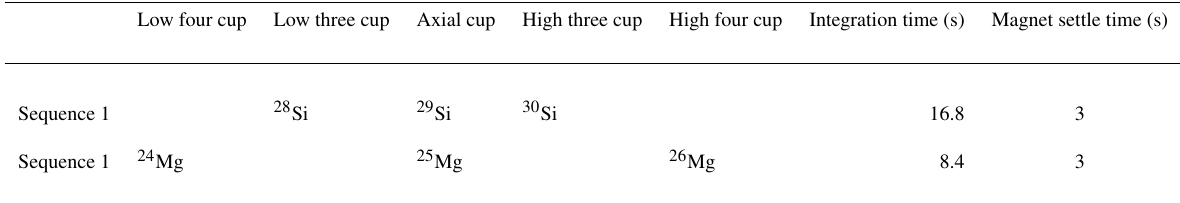
Table 2. Summary of the acquisition method used for Si isotope